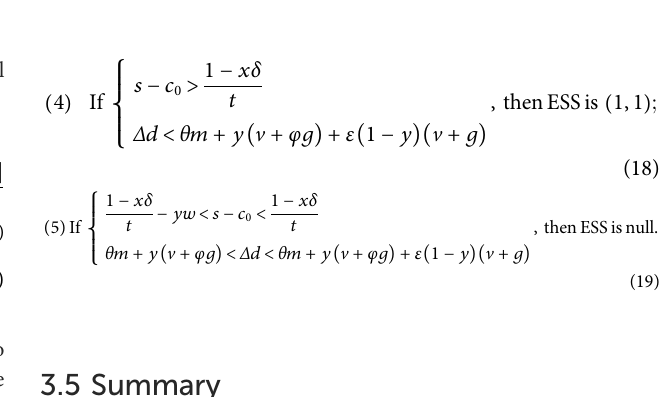
Model building Analysis of